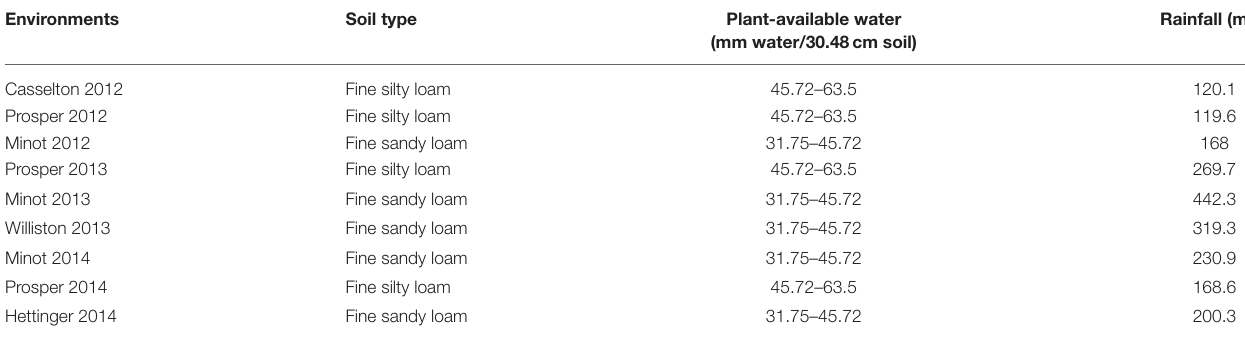
TABLE 1 | Soil types, plant-available water (water-holding capacity of soil), and total rainfall for nine environments used in this study.